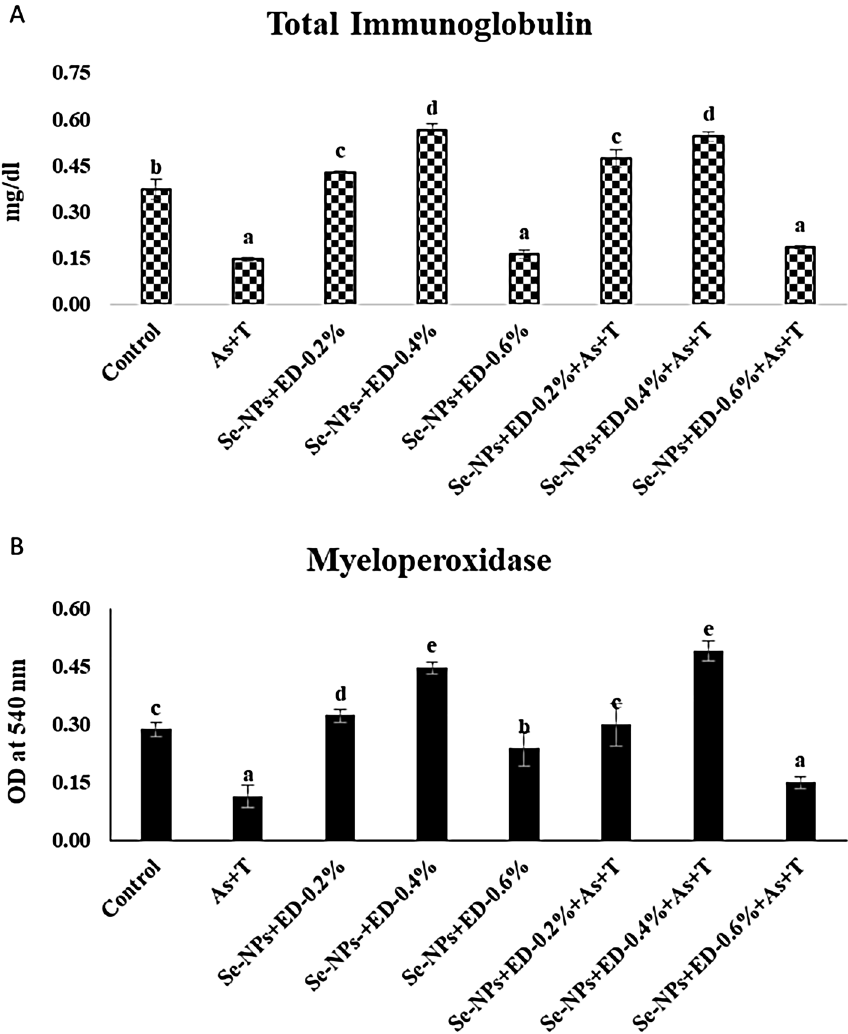
Figure 4. ( A , B ) Mitigation of secondary stress response (total immunoglobulin and myeloperoxiadase) through dietary supplementation of selenium nanoparticles, eicosapentanoic acid and dicosahexanoic acid fed to P. hypophthalmus reared in control or under arsenic and high temperature (As + T) for 105 days. Within endpoints and groups, bars with different superscripts differ significantly (a–f) Total immunoglobulin (p = 0.0042), Myeloperoxidase (p = 0.017). Data expressed as Mean ± SE (n =